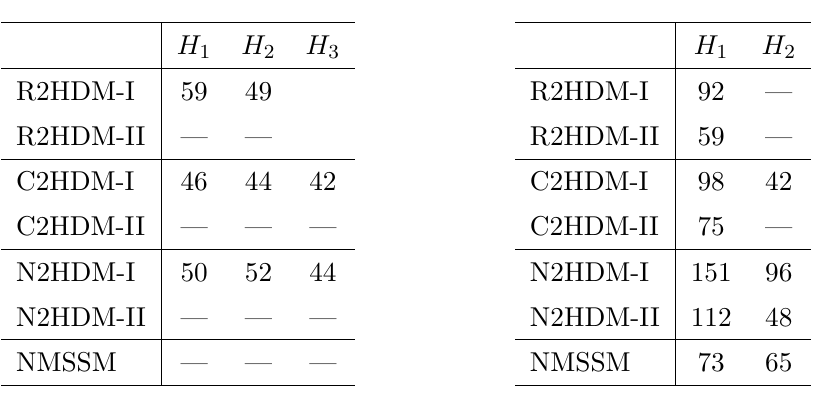
Table 6 . Maximum NLO QCD gluon fusion cross section values in fb for the case where H SM ≡ H 1 , H 2 , and H 3 , respectively, in the R2HDM-I/II, C2HDM-I/II, N2HDM-I and NMSSM. Left: scenarios with m 2 m ; right: scenarios with suppressed resonance contributions (cf. H i 6 = H SM < H SM